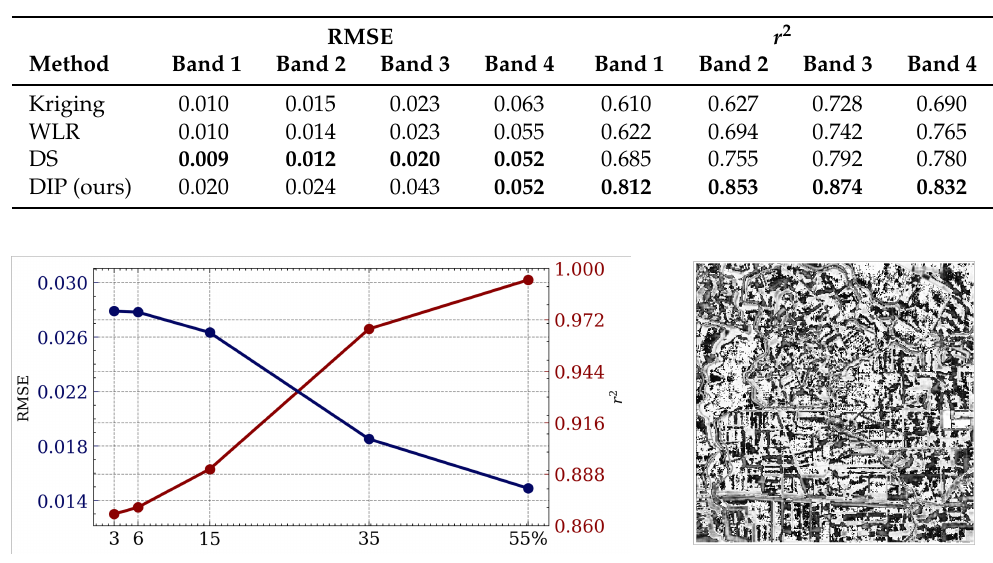
Table 1. Comparison of performance of different popular gap-filling methods [17] and deep image prior. Bold text highlights the best value for a band. The DIP approach outperformed the other methods according to r 2 score for all bands.